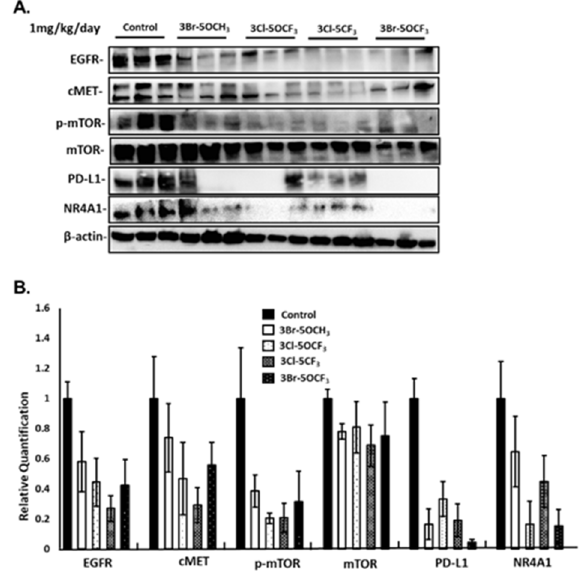
Figure 7. In vivo studies: analysis and quantitation of gene products. ( A ) Tumor lysates from the in vivo studies (Figures 5 and 6) were analyzed by western blots and band intensities were quantitated ( B ) relative to β -actin, as outlined in the Materials and Methods section.